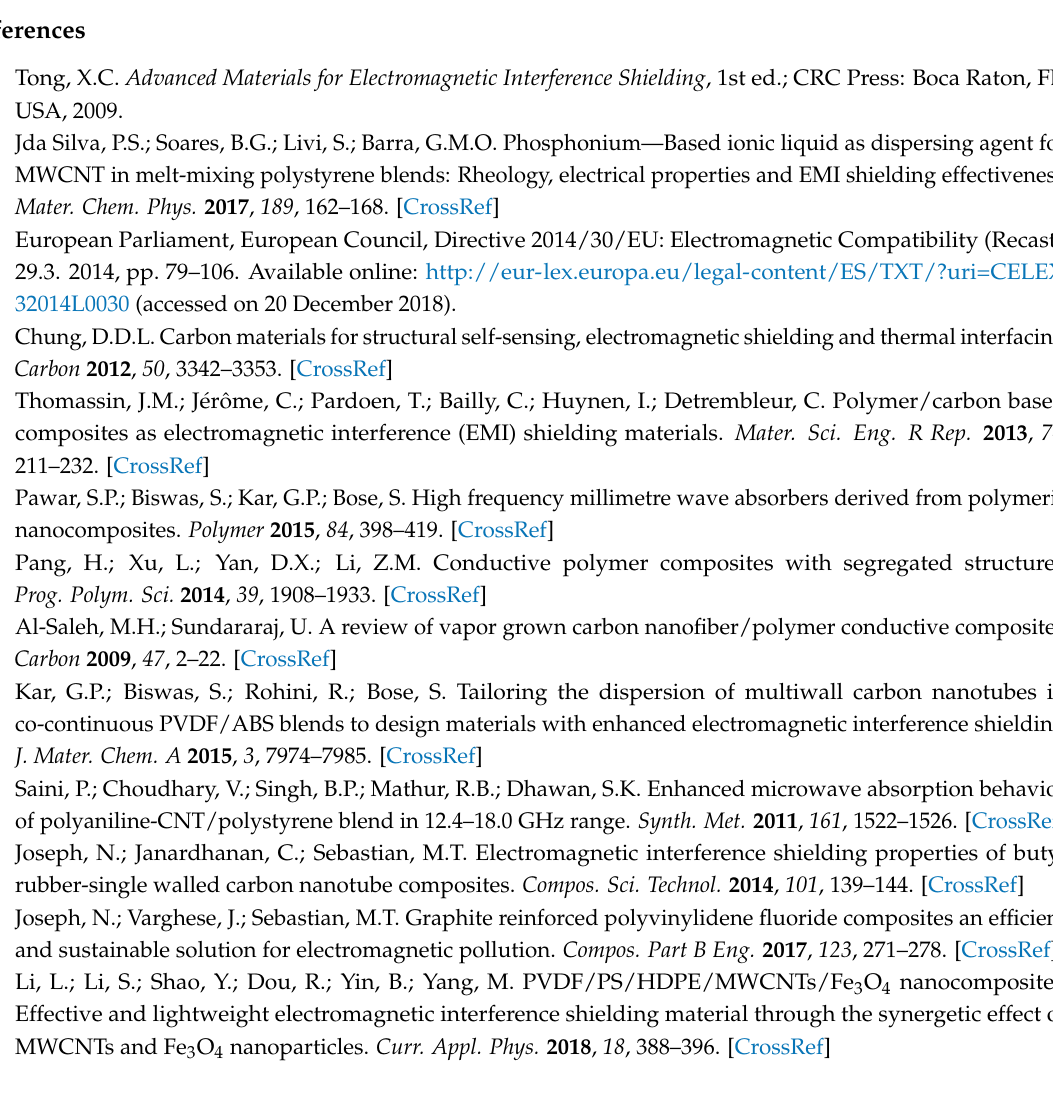
Figure S2: EMI shielding by absorption of ABS and composites: compression moulded (upper left graph), FDM-PC (upper right graph), FDM-HC (lower left graph) and FDM-H45 (lower right graph), Figure S3: EMI shielding by reflection of ABS and composites: compression molded (upper left graph), FDM-PC (upper right graph), FDM-HC (lower left graph) and FDM-H45 (lower right